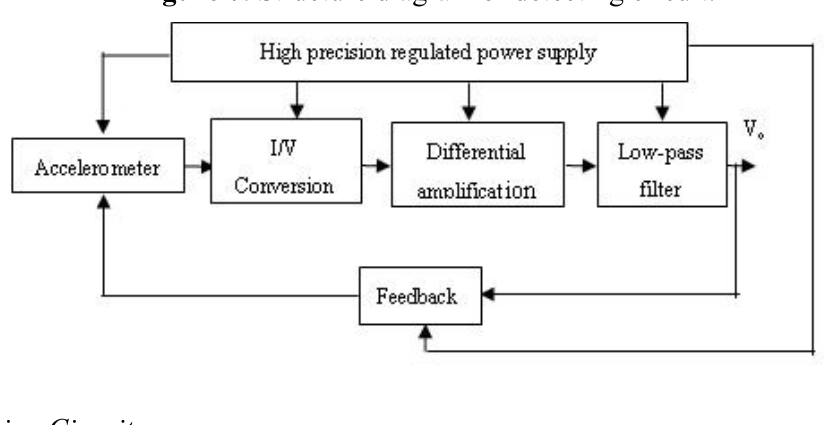
Figure 7. Structure diagram of detecting